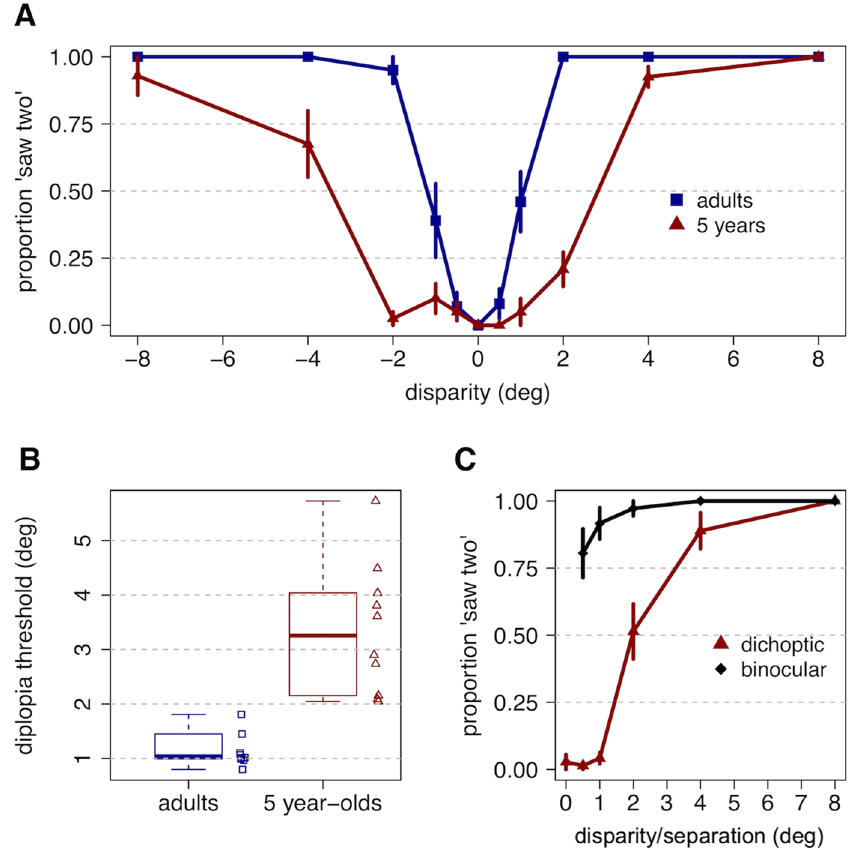
Figure 1. ( A ) Mean proportion of trials for which participants reported seeing two (rather than one) characters as a function of disparity, for adults (n = 10) and 5-year-olds (n = 10). Error bars reflect standard error across participants. ( B ) The median and distribution of participants’ 63% diplopia thresholds, collapsed across sign, for each age group. Symbols to the right represent individual participant estimates. C: Mean proportion of stimuli reported as ‘saw two’ by the group of 5-year-olds who took part in the interleaved binocular control condition, collapsed across disparity sign. Error bars reflect standard error across